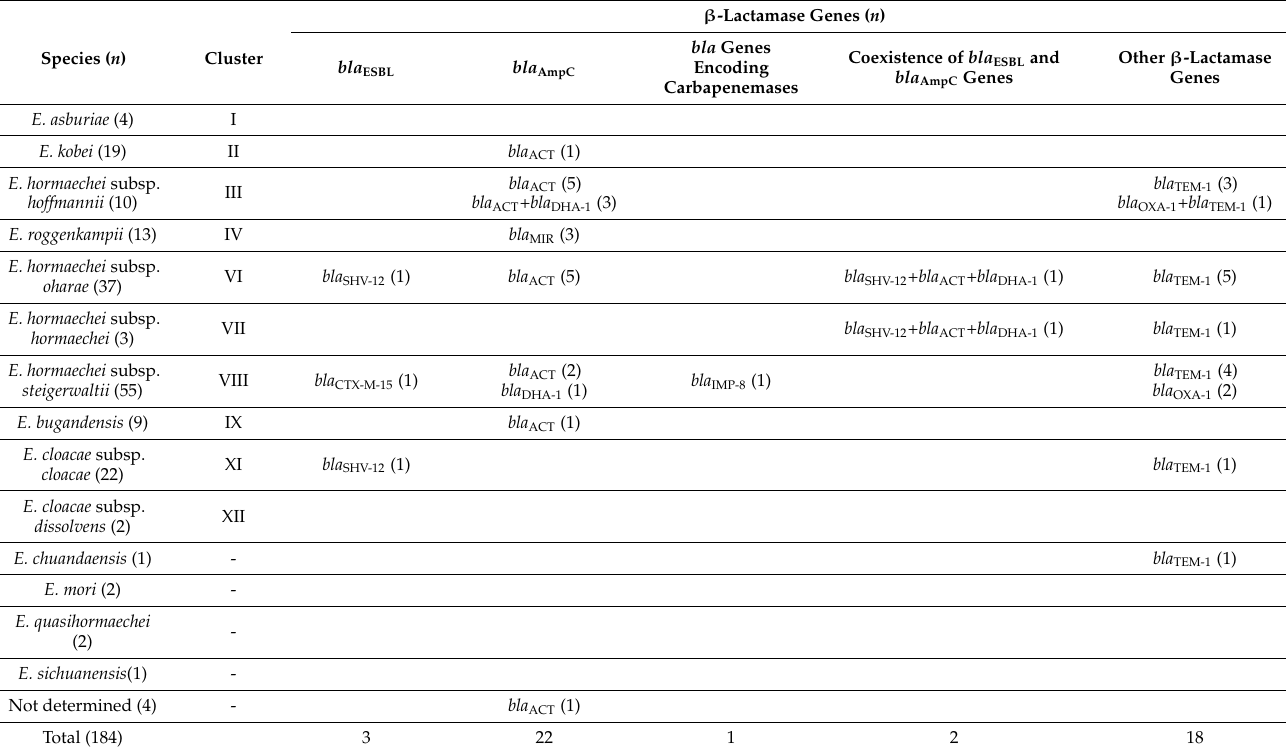
Table 3. Distribution of β -lactamase genes in species of Enterobacter